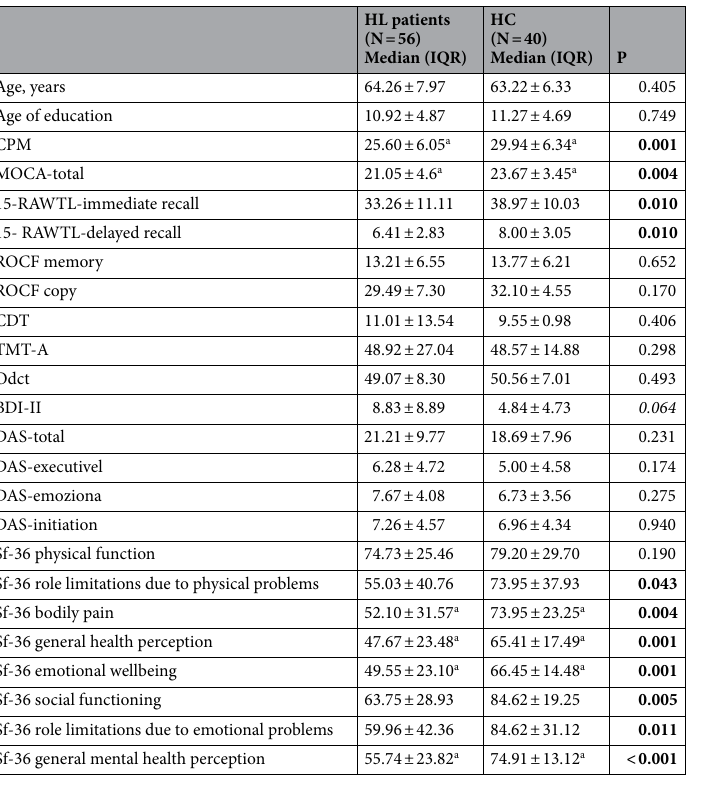
Table 1. Demographic, neuropsychological and behavioral features in HL patients and healthy controls. Statistically significant differences are indicated in bold. The trend towards statistical significance is indicated in italics. 15-RAWLT Rey’s auditory 15-word learning test- Verbal immediate recall; 15-RAWLT, Rey’s auditory 15-word learning test- Verbal delayed recall; BDI-II; Beck Depression Inventory II;CDT, Clock Drawing Test; CPM, Raven’s Coloured Progressive Matrices; DAS, Dimensional Apathy Scale; HC, Healthy controls; HL, hearing loss; IQR, Interquartile ranges; MOCA, Montreal Cognitive Assessment; N, simple size; oDCT, Digit Cancellation Test; ROCF, Rey-Osterrieth Complex Figure Test; SF 36, Short form 36; TMT-A, Trail Making Test Part A. a HL patients vs HC corrected for p ≤